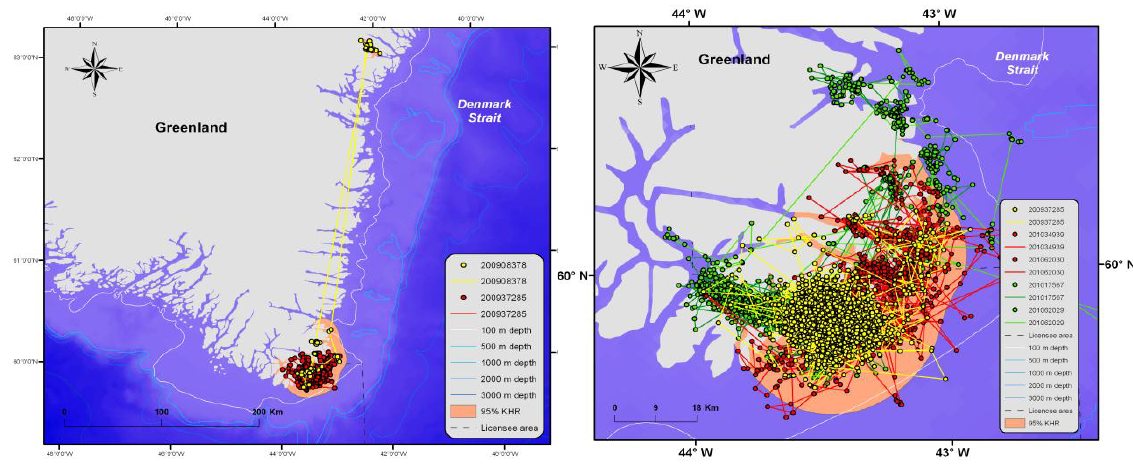
Figure 2. Positions (right) near Cape Farewell of one bearded seal tagged in September 2009 and two in September 2010, and long-distance movement northward from the seal tagged in 2009 (left). Contact with the three seals lasted over 11 months, up to 399 days (Rosing-Asvid et al.,